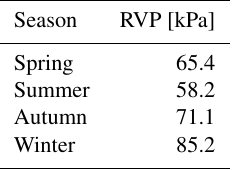
Table 4. HBEFA seasonal values for fuel Reid vapor pressure for Germany.